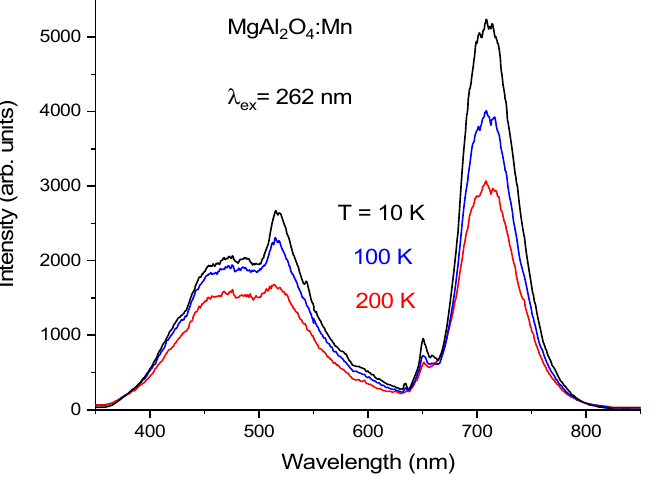
Figure 5. PL spectra of sample II, i.e., MgAl 2 O 4 :Mn, measured at different temperatures: 200 K, 100 K, and 10 100 K, and 10 K. K.